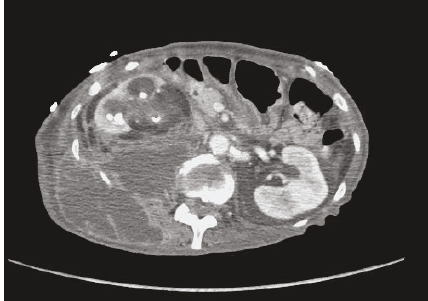
Figure 1: Axial section of a CT scan of the abdomen/pelvis with IV contrast demonstrating severe right hydronephrosis communicat- ing with a large retroperitoneal fluid collection.